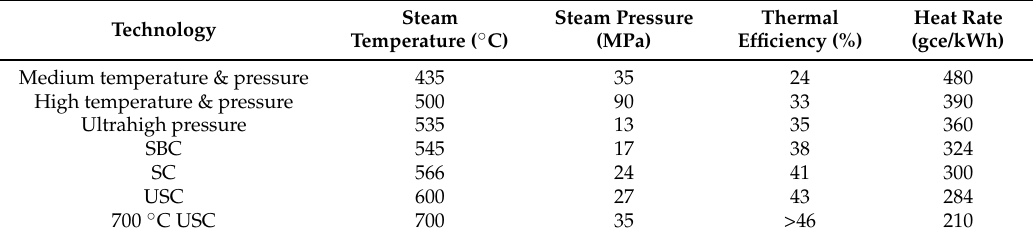
Table 7. Thermal efficiency and heat rate of various coal generation technologies [48].